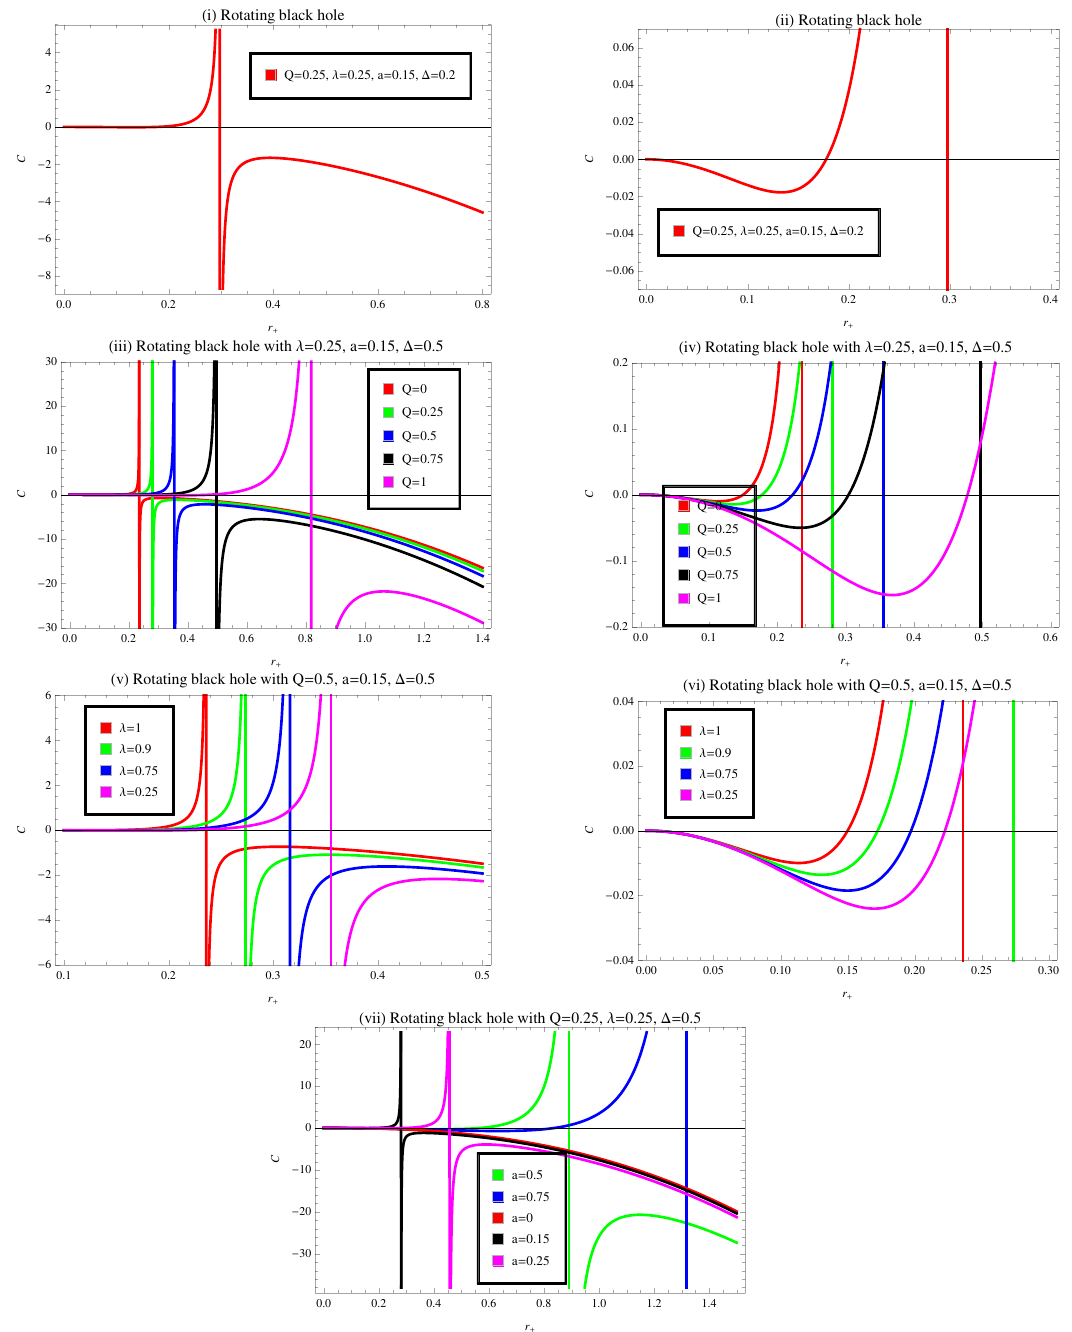
Figure 8. Plot of heat capacity C v versus horizon radius r + for rotating regular BH in the presence of CMG